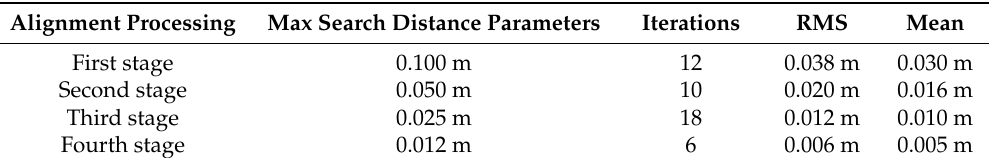
Table 3. Overlap error statistics between the laser scanning and photogrammetry according to alignment stages.